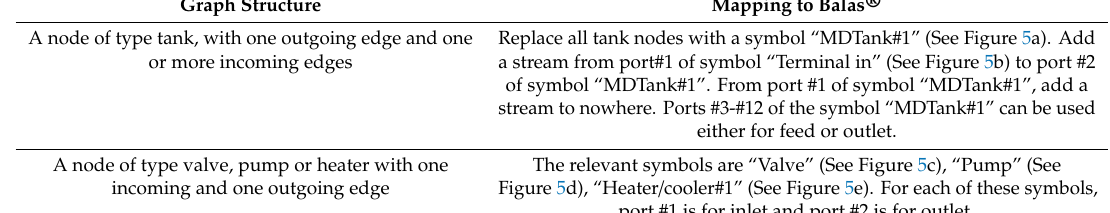
Table 1. Rules for a one-to-one mapping from an intermediate graph to a steady state model. Graph Structure